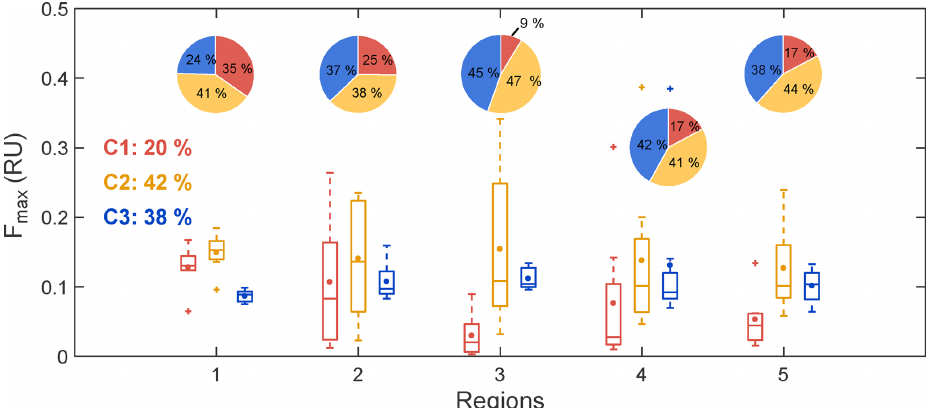
Figure 5. Variations of fluorescent components among regions. The box plots show the F max of different components. The boxes denote the 25th and 75th quantiles, and the horizontal lines represent the 50th quantiles (medians), the averages are shown as dots; the whiskers denote the maximum and minimum data within 1.5 times the interquartile range, and the data points out of this range are marked with crosses ( + ). The pie charts show the regionally average relative contributions of three components. C1, C2, and C3 are represented in red, yellow, and blue, both for the box plots and pie charts. The percentages on the left of the panel are the averages of %C1–%C3 for the whole data set.